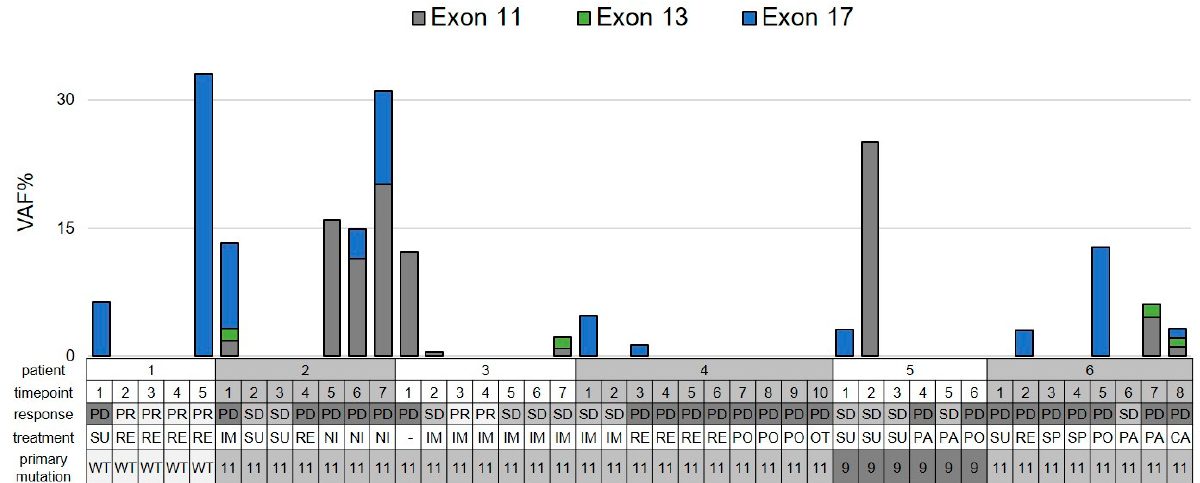
Figure 5. Longitudinal assessment of KIT mutations in GIST patients. Variant allele fractions (VAF) are displayed for each timepoint. Mutations of each exon were grouped. In case of multiple samples per timepoint mean VAF is shown. Y: yes; PD: progressive disease, SD: stable disease, PR: partial remission; IM: imatinib, SU: sunitinib, RE: regorafenib; NI: nilotinib; PO: ponatinib; OT: other; PA: